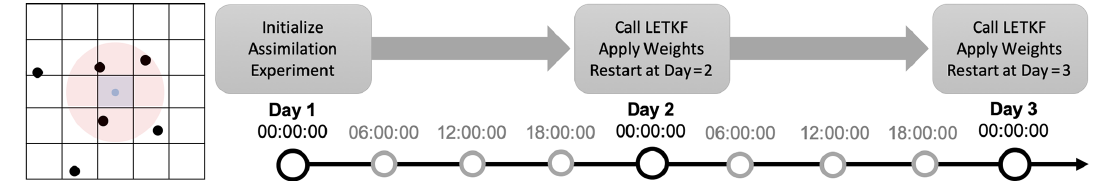
Figure 4. On the left side, the grid-cell-scale collocation of the assimilated grid and the surrounding observations is illustrated. The high- lighted blue area denotes the assimilated grid cell, the red circle around it represents the local patch size ( L x ), and black dots represent the observations. It is noted that in LETKF the L x distance is represented in grid cell units, but for illustrative purposes here it is represented as a circle. On the right side, the daily assimilation cycle is depicted for